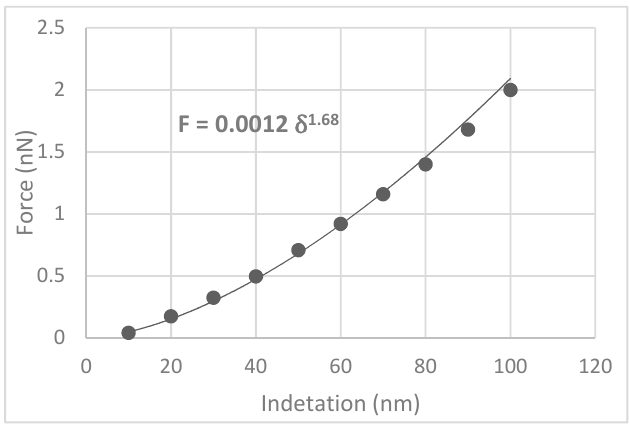
Figure 5. Force-indentation data obtaining from finite element model (FEM) (solid dots) and fitted curve (solid line).